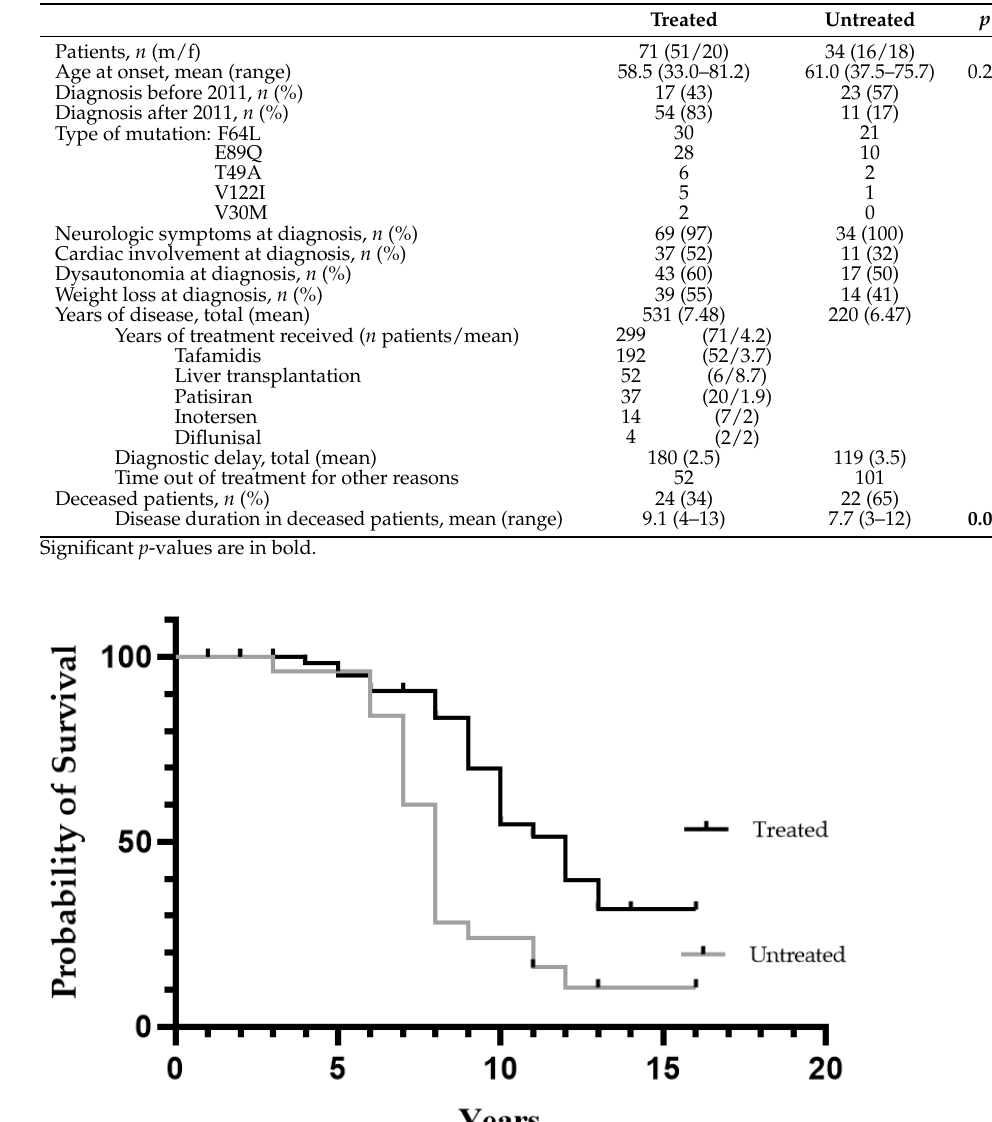
Table 2. Comparison of treated vs. untreated patients and details of treatments received.